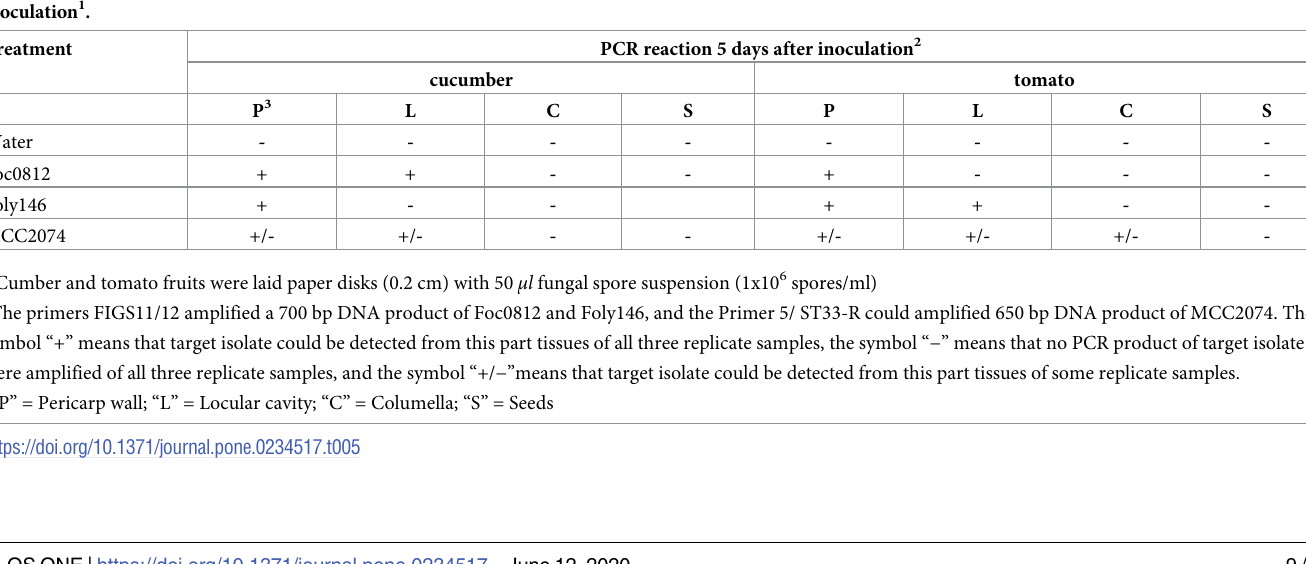
a The hypocotyl and stem tissues were cutted into pieces (about 1 cm each) from the bottom to the top. The numbers indicated the height of the tissues. The “CN” means the cotyledonary node, the “CN-1” means the region that under 1 cm of the CN, and the “Stem 30” means the region that above 30 cm of the CN. b The primers Primer5/ST33-R could amplified 642 bp DNA product ofMCC2074. The symbol “+” means that MCC2074 could be detected from this part tissues of all three replicate samples, the symbol “ − ” means that no PCR product of MCC2074 were amplified of all three replicate samples, and the symbol “+/ − ”means that MCC2074 could be detected from this part tissues of some replicate samples.